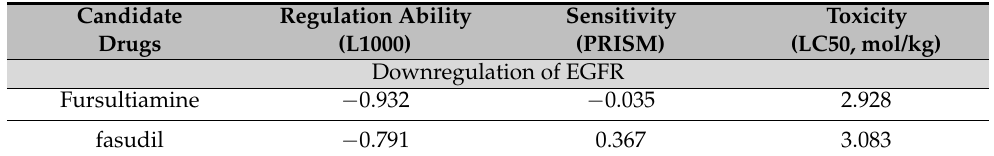
Table 5. According to drug design specifications, the candidate drugs for each significant drug target are list